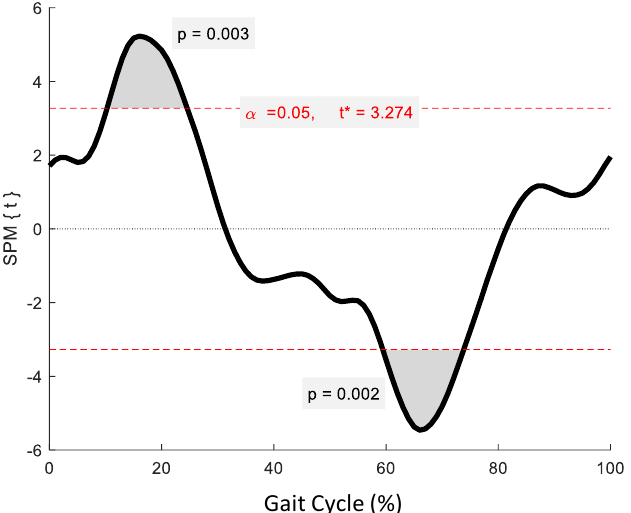
Figure 4. Statistical Parametric Mapping (SPM) output for pelvic kinematics in the coronal plane. The horizontal red dashed lines represent the critical t * based on α = 0.05 and random field theory calculations of residual smoothness. t * is the critical threshold.